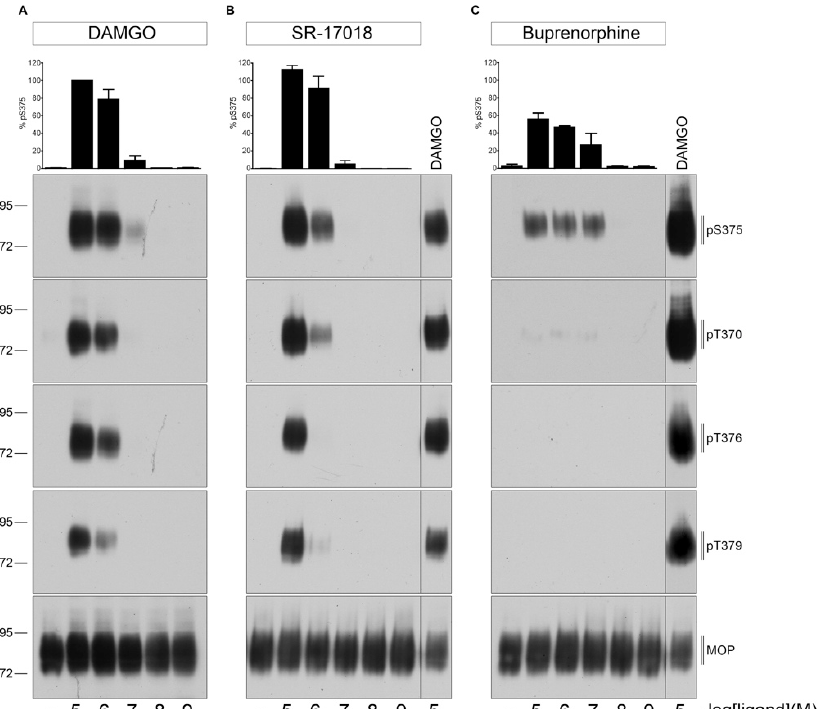
Figure 2. Dose-dependent multisite phosphorylation by DAMGO, SR-17018, and buprenorphine. HEK293 cells stably expressing HA-MOP were either treated with ( A ) DAMGO, ( B ) SR-17018, or ( C ) buprenorphine with concentrations ranging from 10 µM to 1 nM for 30 min at 37 °C. Cells were lysed and immunoblotted with the anti-pT370 (pT370), anti-pT376 (pT376), anti-pT379 (pT379), or anti-pSer375 (pS375) antibodies. Blots were stripped and reprobed with the phosphorylation-independent anti-HA-tag antibody to confirm equal loading of the gels. S375 phosphorylation was quantified (upper panel) and expressed as percentage of maximal phosphorylation in control cells, which was set at 100%. Data correspond to mean ± SEM from three independent experiments. Positions of molecular mass markers are indicated on the left (in kDa). (( B , C ) right lane) 10 µM DAMGO samples were used as a control to visualize different development times on X-ray films. Blots are representative of three independent experiments.